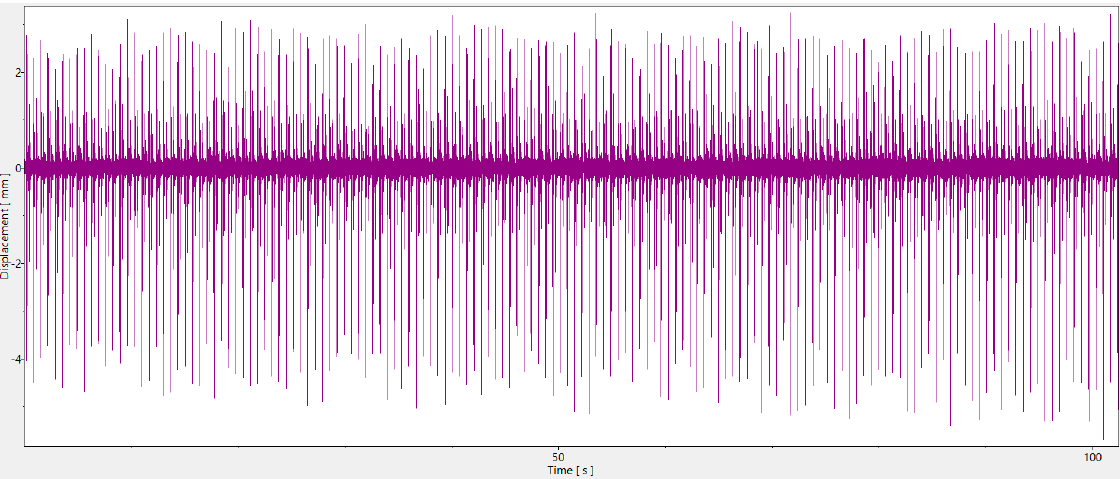
Figure 13. Plot of the vertical displacement measurement at the G3 (B) measuring point for an interval of 40 s; the maximum vertical displacement is 5.18 mm.